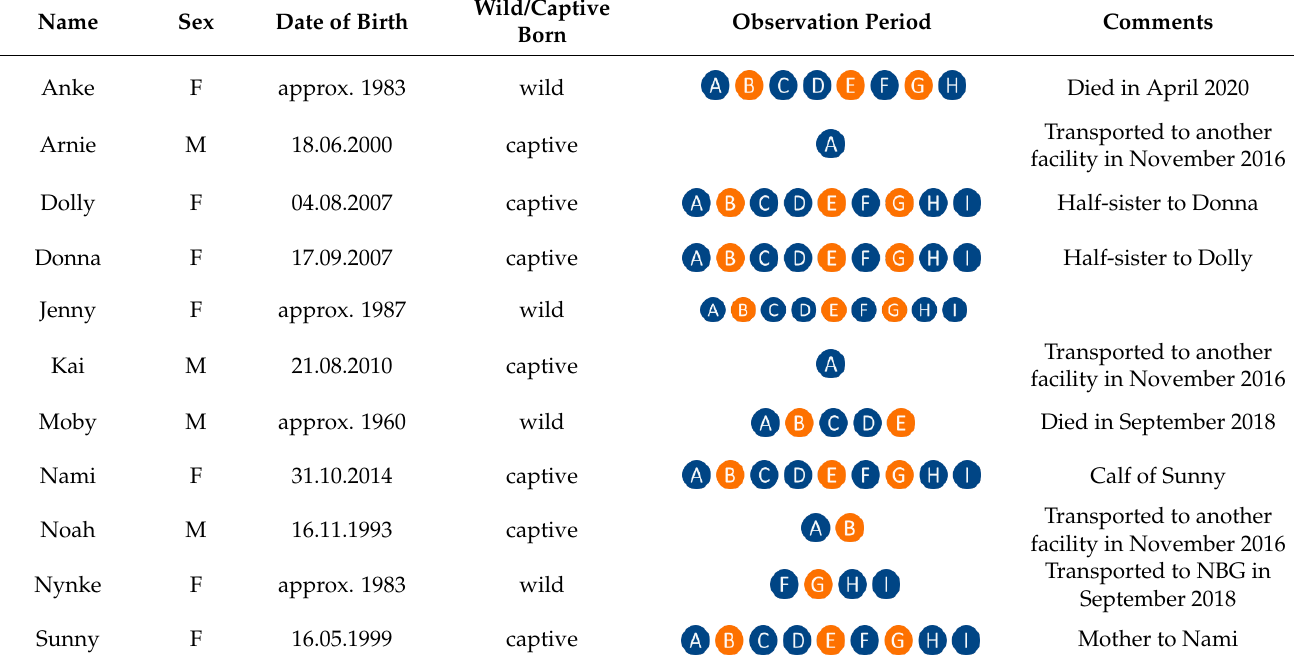
Table 1. List of the individuals observed over the five-year span. The observation periods in which there was construction noise are highlighted in orange. Arnie, Kai, and Noah were not included in the dataset, if not stated otherwise, because they were observed for only one (Arnie and Kai) or two (Noah) observation periods.